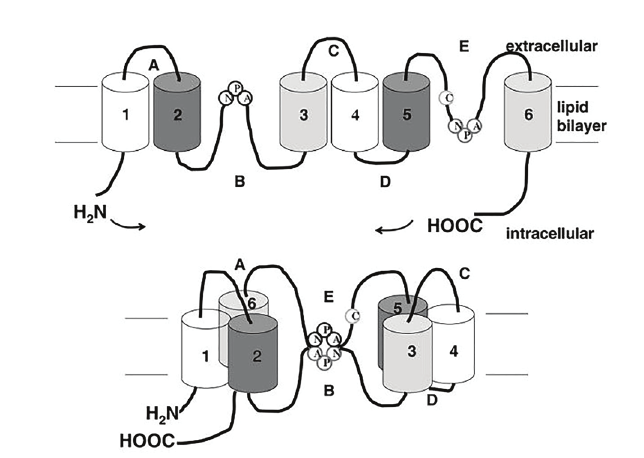
Figure 1. Structure of Aquaporin-[13] and surrounded by transmembrane domains where they form